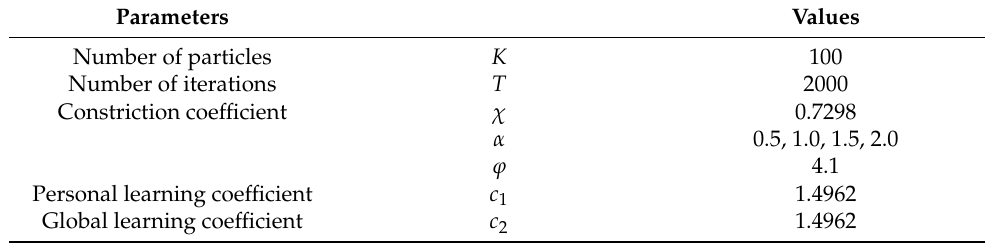
Table 2. Statistical randomization-based particle swarm optimization (SR-PSO) algorithm’s parame- ters settings in the